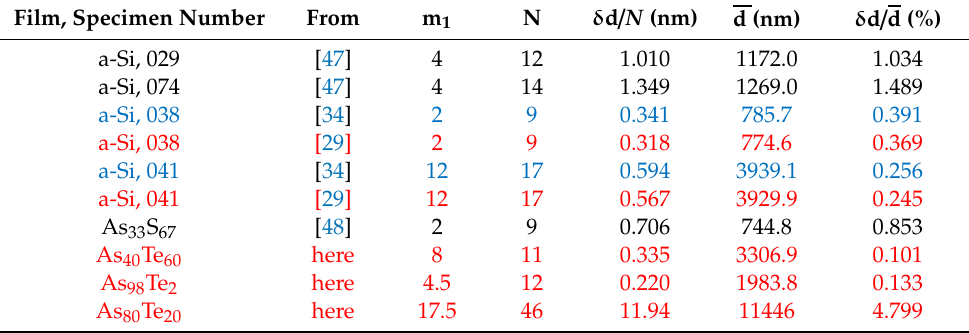
Table 3. Data regarding the relative error δ d / d for the characterizations of As x Te 100 − x films and for recent film characterizations based on the FEM and the AOEM. The data about characterizations based on the FEM are in black, the data for characterizations using the OEM are in blue, and the data for characterizations based on the AOEM are in